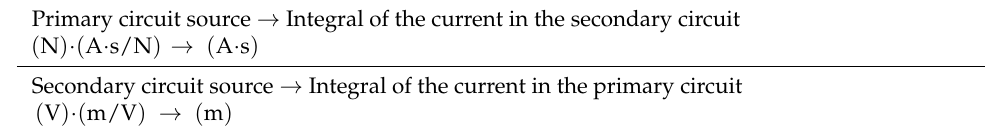
Table 3. Unit conversion according to the ratio of the piezoelectric load constant. Primary circuit source → Integral of the current in the secondary circuit ( N ) · ( A · s/N ) → ( A · s ) Secondary circuit source → Integral of the current in the primary circuit ( V ) · ( m/V ) → ( m